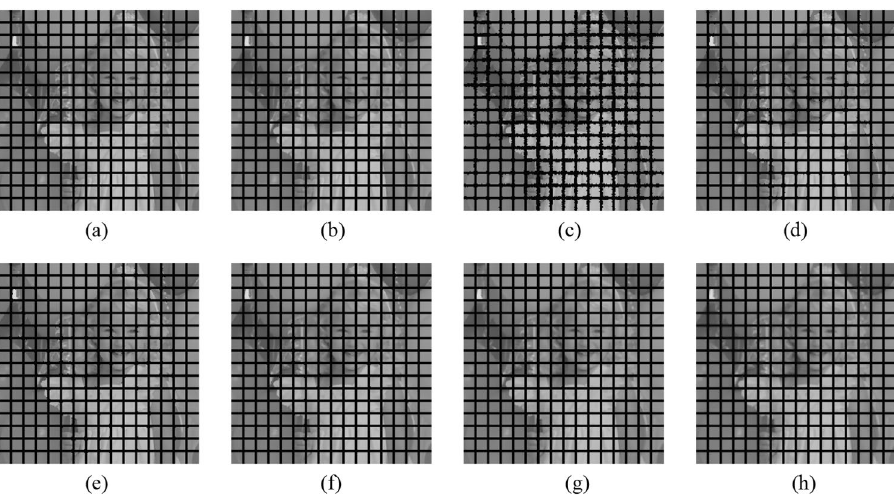
Figure 34. Comparison of edge preservation performance of each filter (“Balloon”). ( a ) Grid-added image; ( b ) filtered image using abwFMGFI; ( c ) filtered image using FMGFI (BW = 1 level); ( d ) filtered image using FMGFI